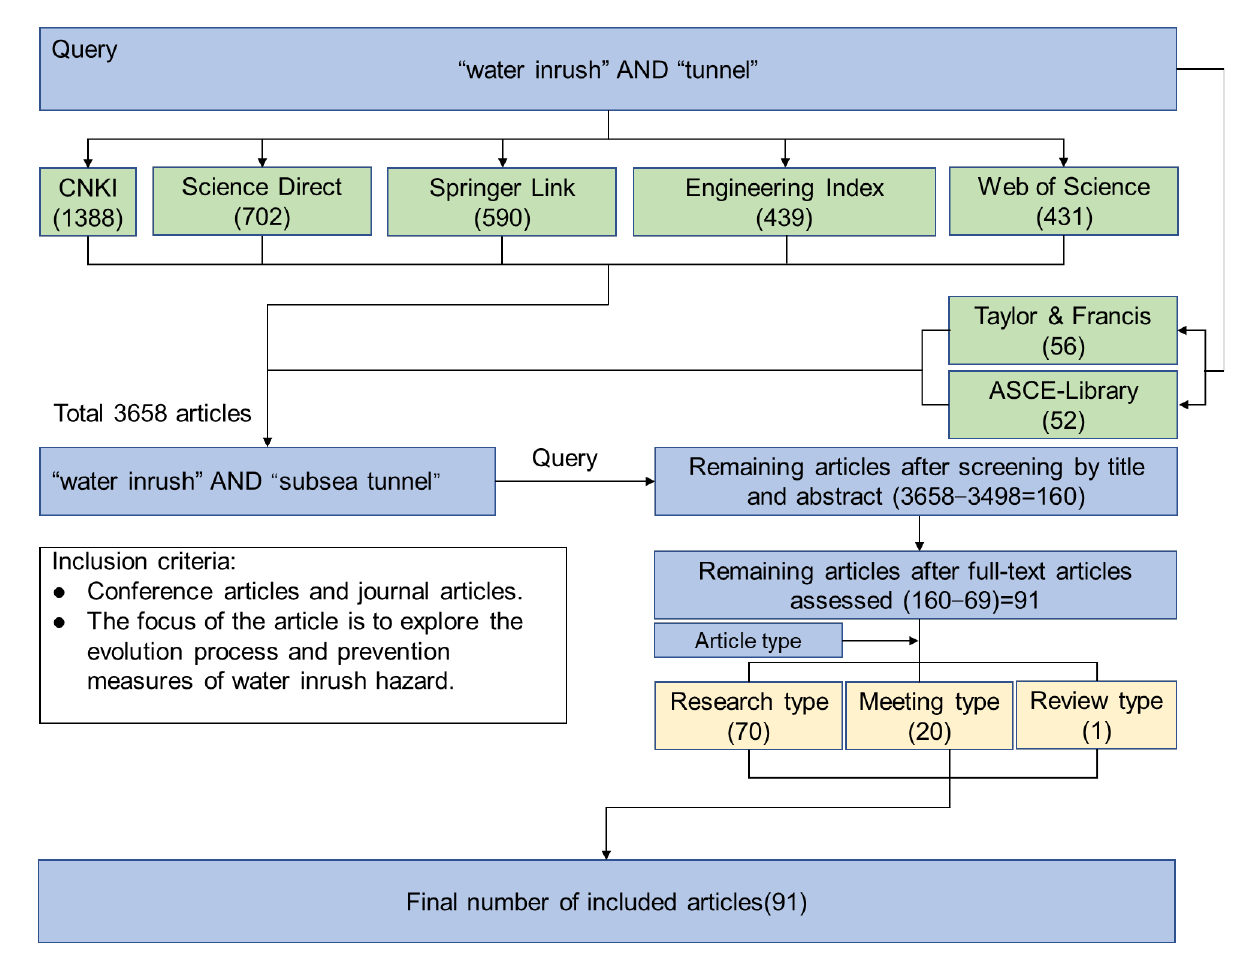
Figure 2. System review process.